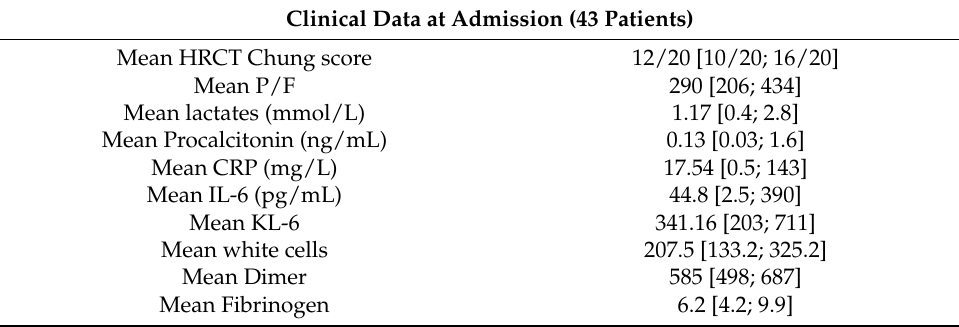
Table 2. Clinical data at